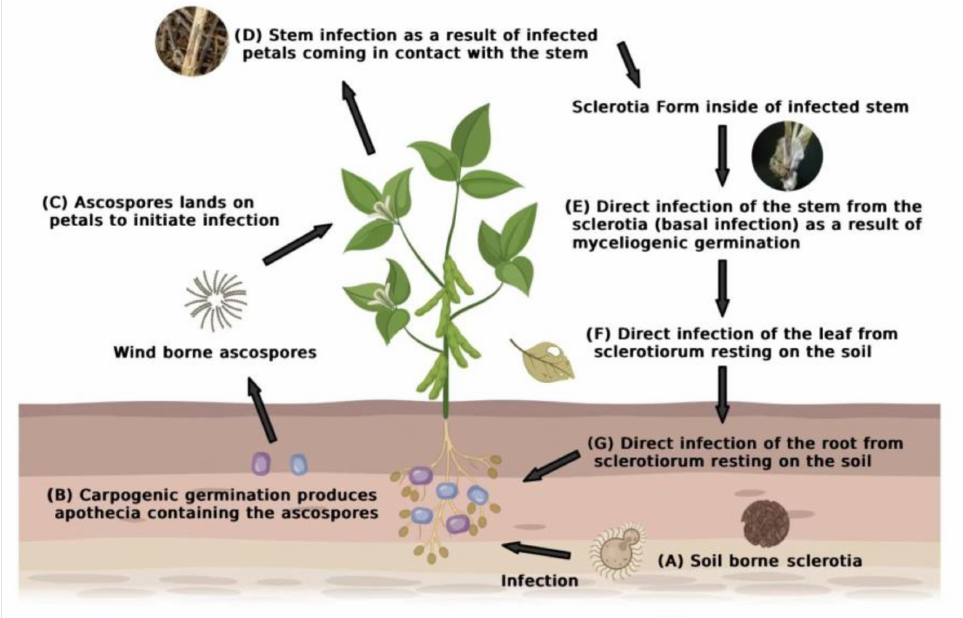
Figure 1. Infection process of S.